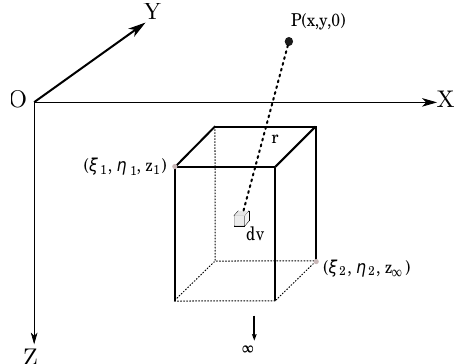
Figure 2. Schema to numerically compute total magnetic anomaly according to Bhattacharyya